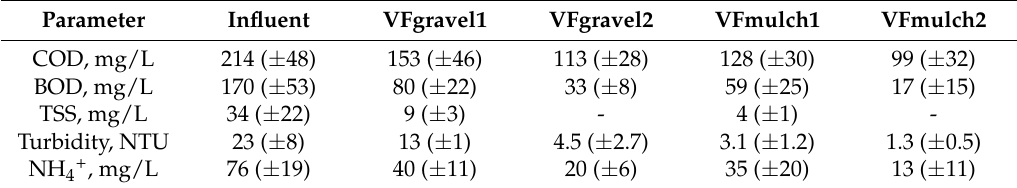
Table 3. Average concentrations ( ± standard deviation) of COD, BOD, TSS, turbidity and ammonia in the influent and the effluents of the first VFs (VFgravel1 and VFmulch1) and second VFs (VFgravel2 and VFmulch2). The number of data of each sample is